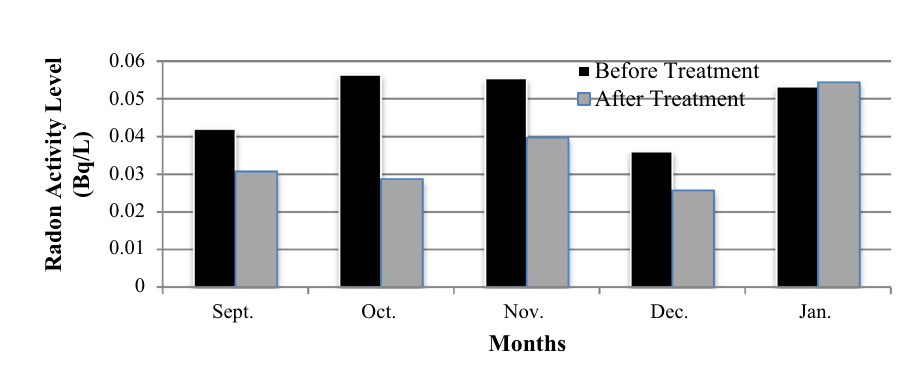
Fig. 4 Dissolved radon concen- trations in wastewater samples before and after